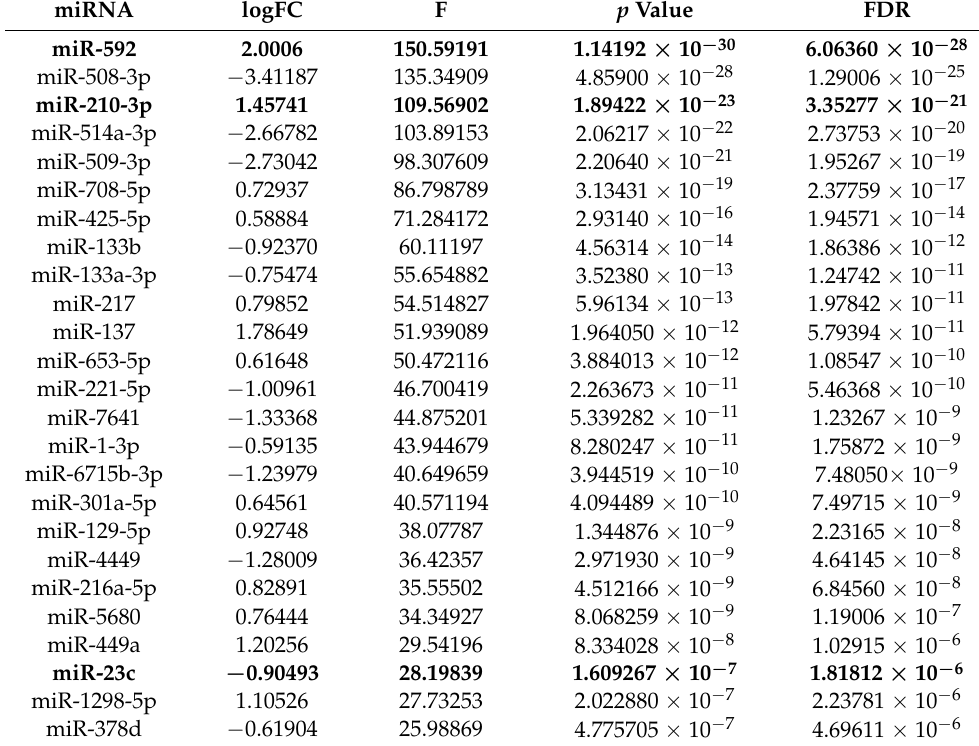
Table 2. Candidate miRNAs for prognosis biomarkers of PC (G1 vs.